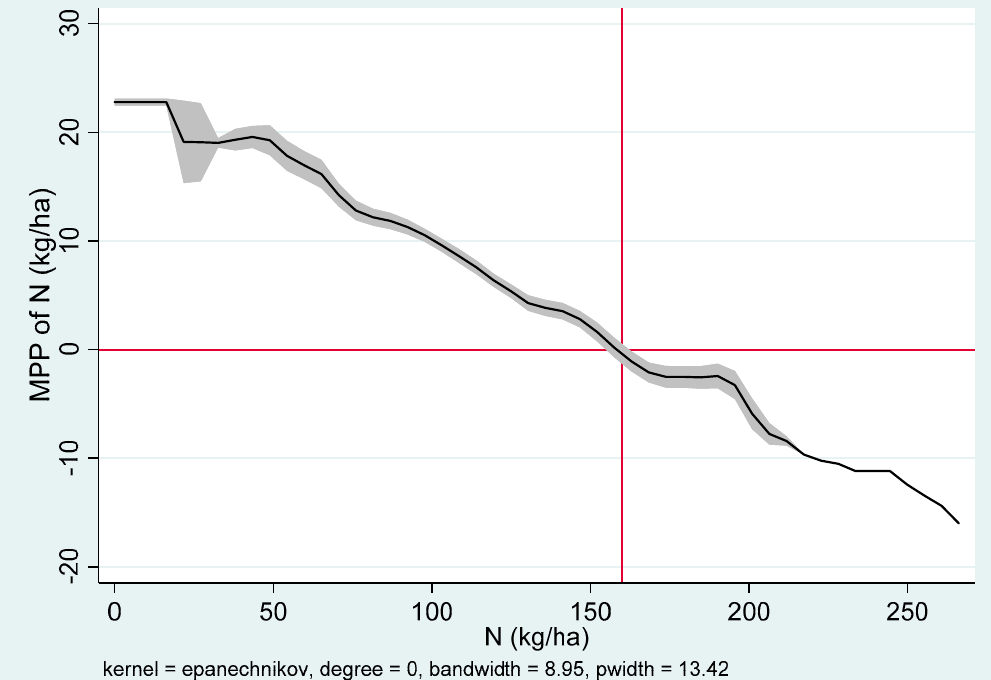
Figure 4. Marginal physical product of N at the mean level in Nueva Ecija, Philippines.